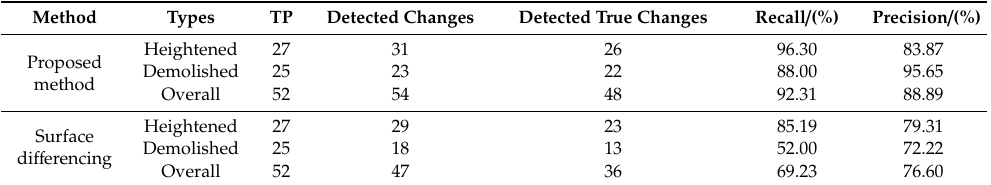
Table 4. Object-based change detection results of Rotterdam